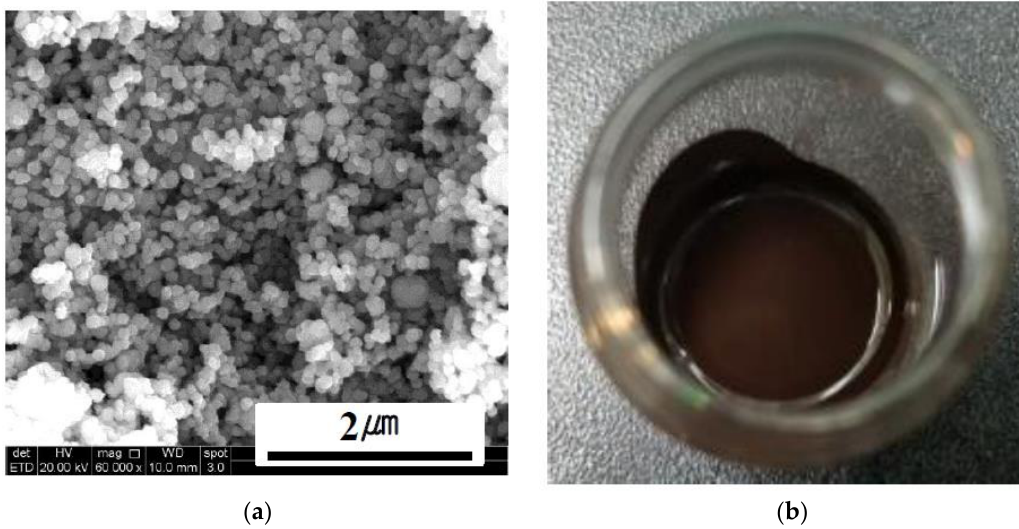
Figure 1. SEM images of the ( a ) Cu nano powders, and ( b ) fabricated Cu paste.